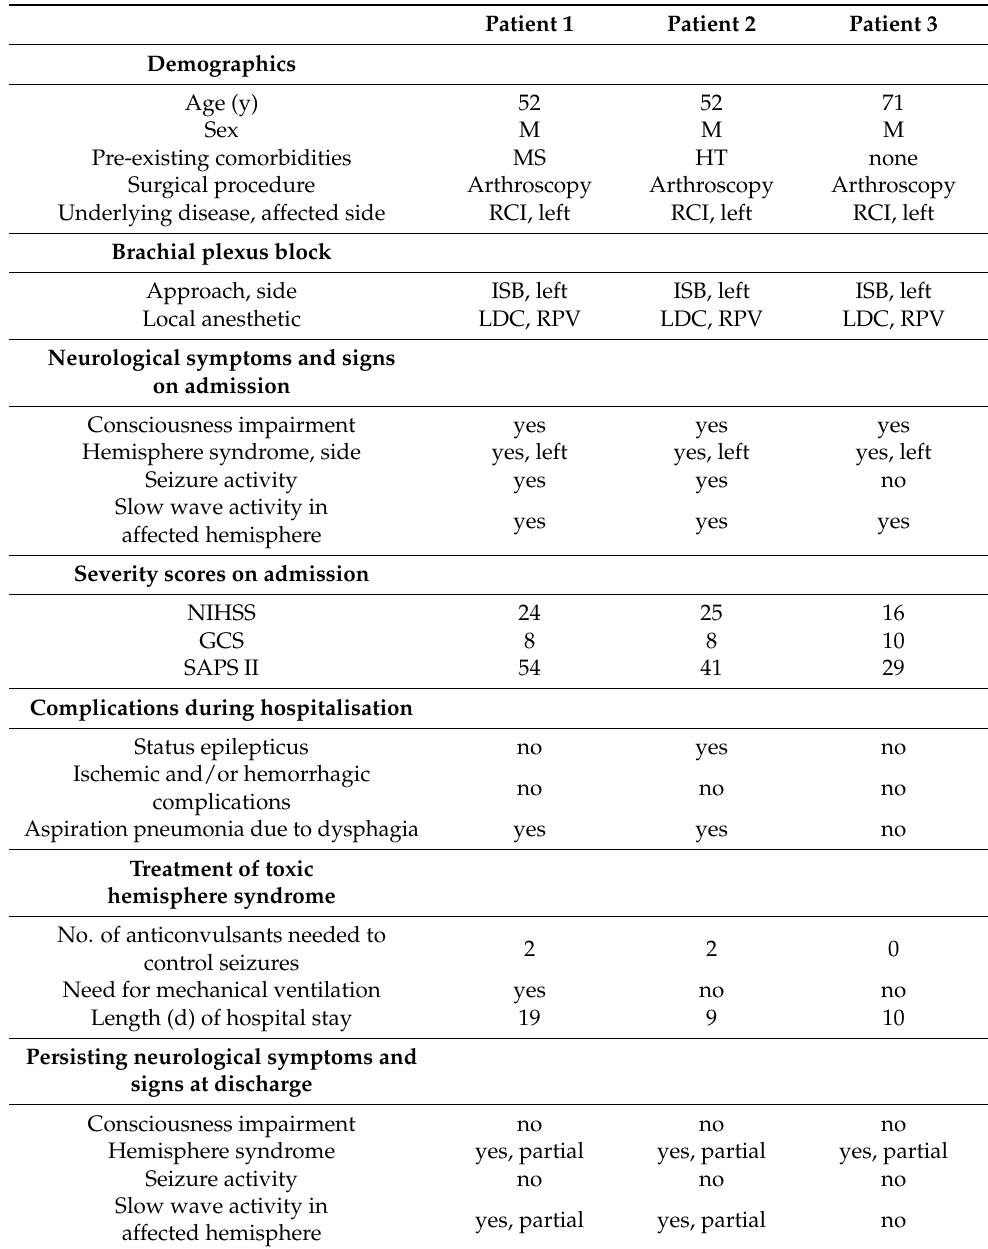
Table 1. Demographic and clinical characteristics of patients with toxic hemisphere syndrome following interscalene brachial plexus